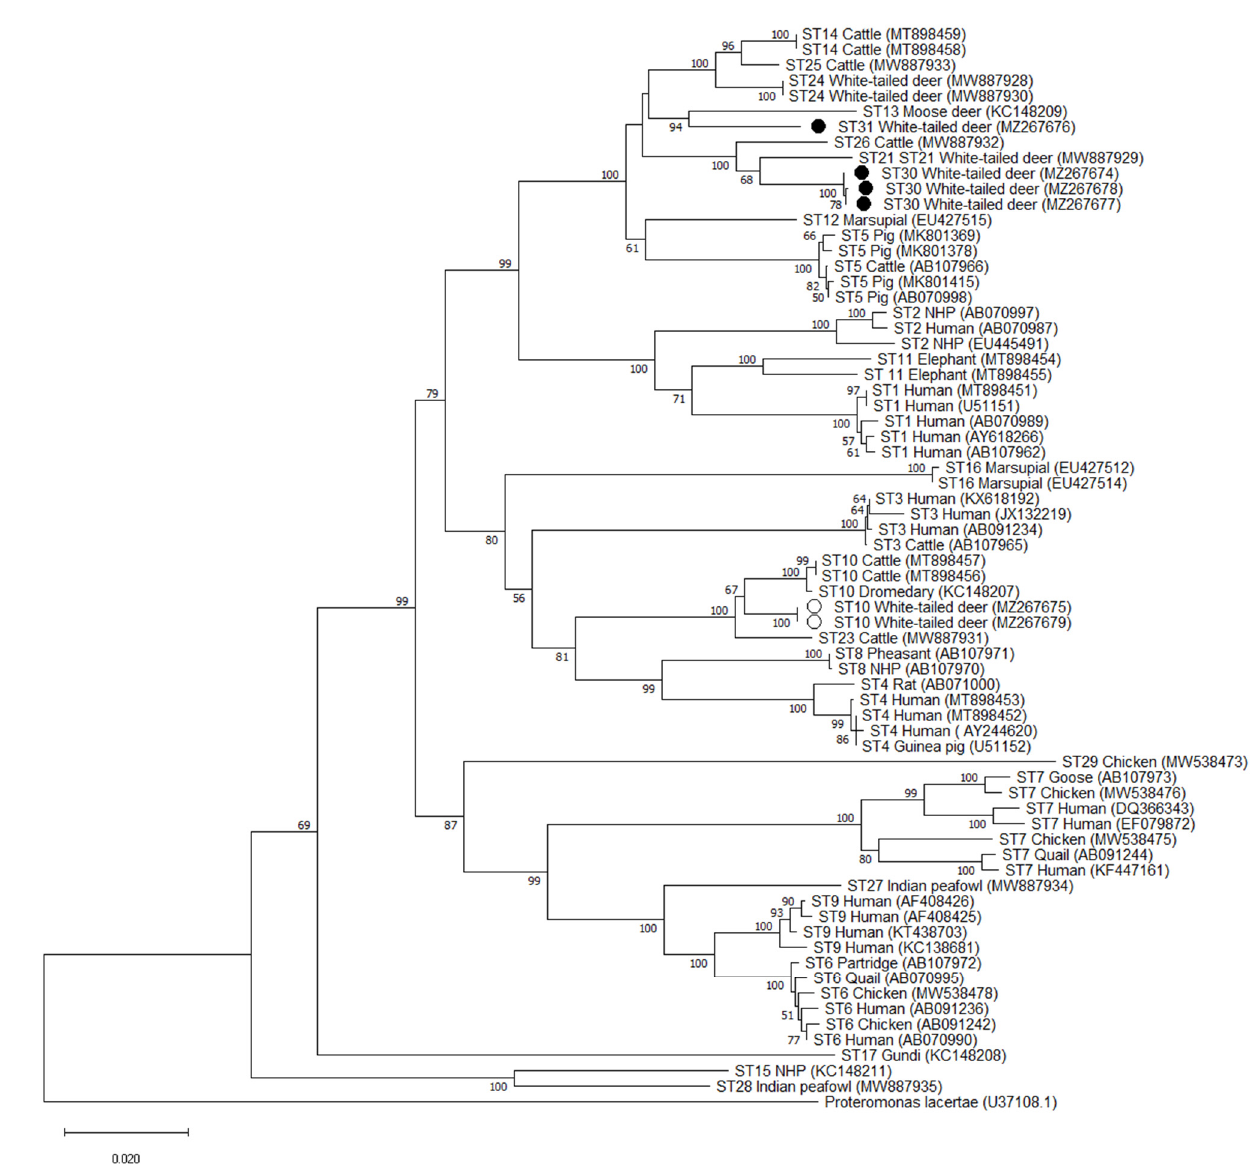
Figure 2. Phylogenetic relationships among Blastocystis full-length sequences generated in the present study (novel subtypes are represented with a black filled circle and other subtypes with an unfilled circle) and representative reference sequences of all accepted subtypes. Proteromonas lacertae was used as outgroup taxon to root the tree. Analysis was conducted by a neighbor-joining method. Genetic distances were calculated using the Kimura two-parameter model. This analysis involved 70 nucleotide sequences, and there were a total of 1950 positions in the final dataset. Bootstrap values lower than 50% are not displayed.